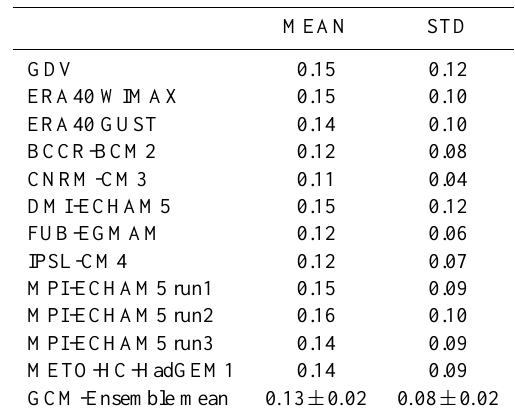
Table 2. Mean annual loss ratios for Germany and interannual stan- dard deviation (STD) as provided by the German Insurance Asso- ciation (GDV) and calculated from the ERA40 reanalysis and the 20C GCM simulations (unit: ‰). The bottom row displays GCM averages ± inter-model standard deviations from the values shown in the preceding nine